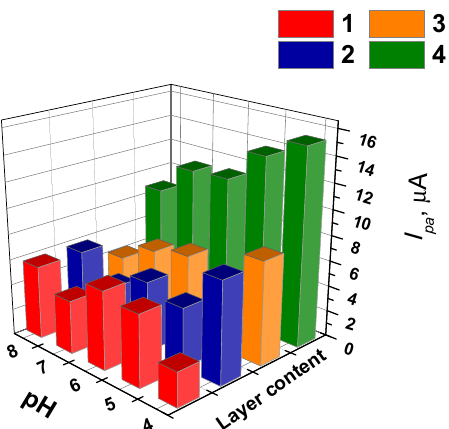
Figure 5. The dependence of the anodic AY peak current on the GCE covered with the CB/AY (1:1) and adsorbed DNA from 1 mg/mL solution (incubation 10 min) on the modification protocol and pH. 1,2—CB suspended in chitosan, 3,4—CB suspended in DMF; 1,3—DMF treatment after the DNA adsorption, 2.4–40 min incubation with DMF.